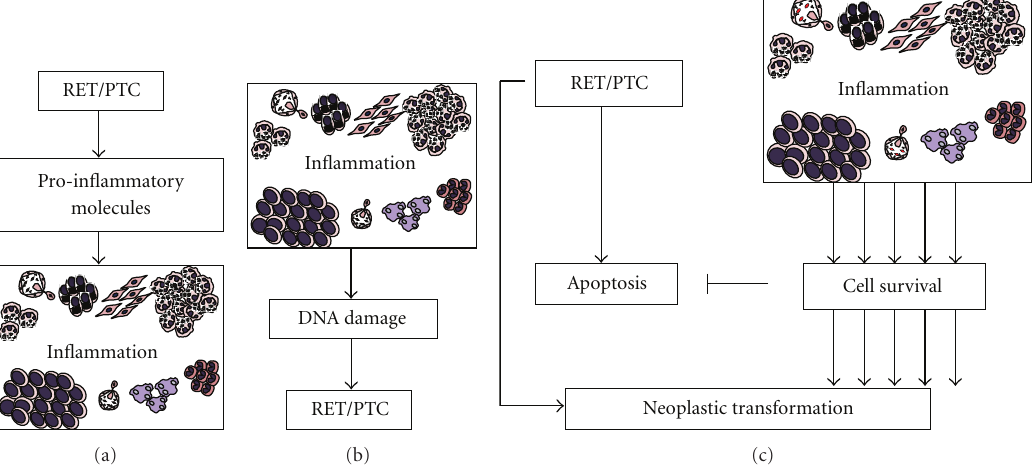
Figure 3: Putative links between RET/PTC rearrangement and concurrent thyroid inflammation. (a) RET/PTC could drive expression of several proinflammatory molecules that may elicit concurrent inflammation. Another possibility (b) is inflammation propitiating RET/PTC rearrangement. Inflammation produces reactive oxygen species and free radicals that may facilitate DNA damage and chromosomal abnormities, like RET/PTC rearrangement. (c) Molecules released by inflammation could sustain the survival of thyroid cells in which RET/PTC rearrangements randomly occur, thereby allowing the selection of clones that acquire additional genetic lesions and thus become resistant to oncogene-induced